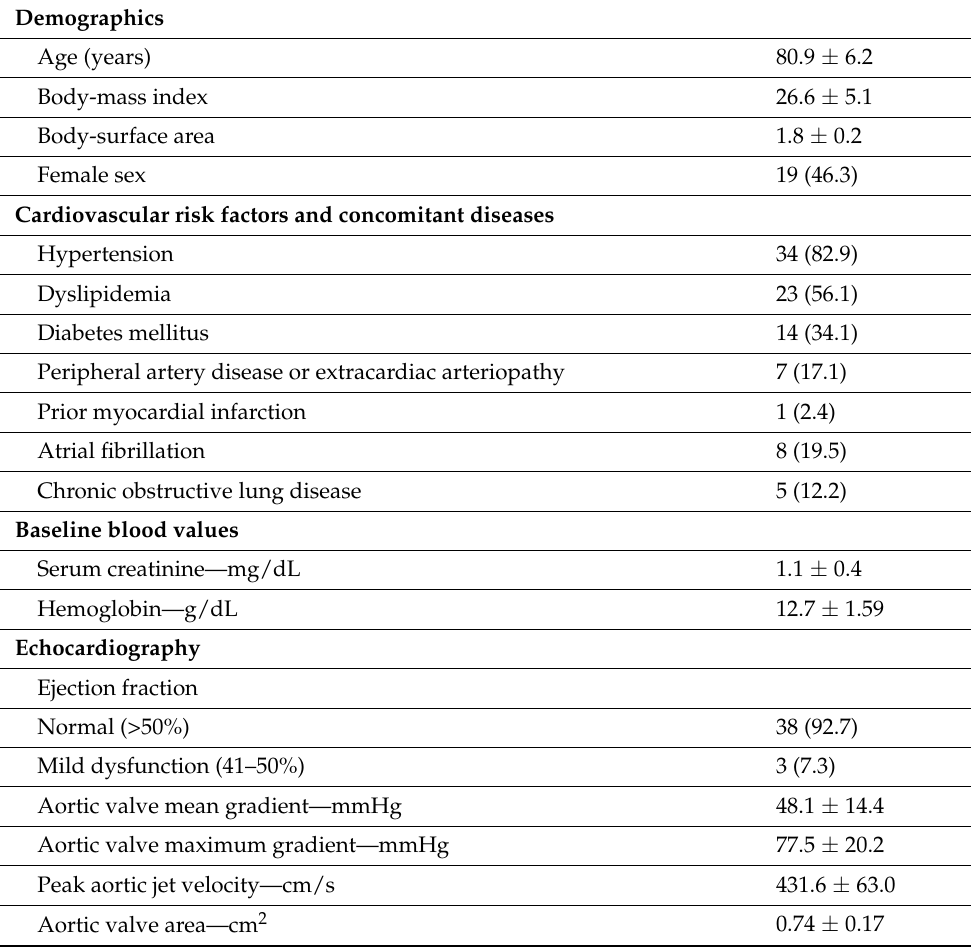
Table 1. Patient characteristics (n =